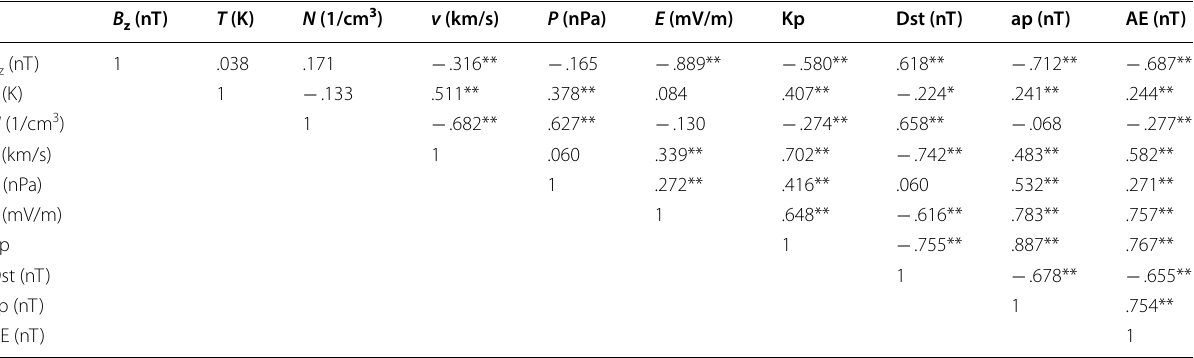
* and ** Correlations are significant at the 0.05 level (two-tailed) and at the 0.01 level (two-tailed),